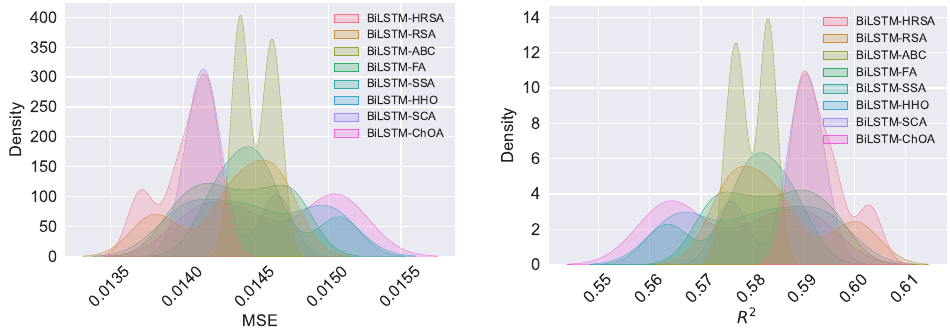
Figure 10. Graphical representation of the Kernel Distribution Estimation plots of BiLSTM in terms of fitness function (MSE) and